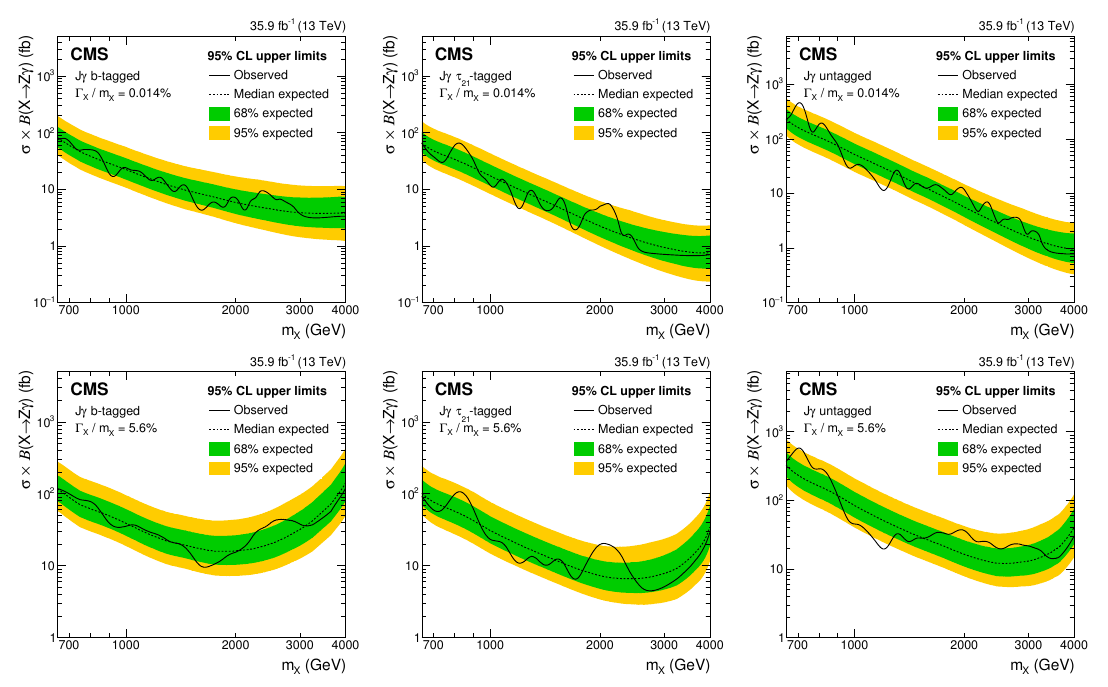
Figure 5 . Observed (solid) and expected (dashed) 95% CL upper limits on (cid:27) (X ! Z (cid:13) ), as a function of signal mass m X , for the b-tagged (left column), (cid:28) 21 -tagged (middle column), and untagged (right column) categories, and for narrow (upper row) and broad (lower row) spin-0 resonances. The colored bands correspond to the 68% (green) and 95% (yellow) CL ranges of the expected limit for the background-only hypothesis.